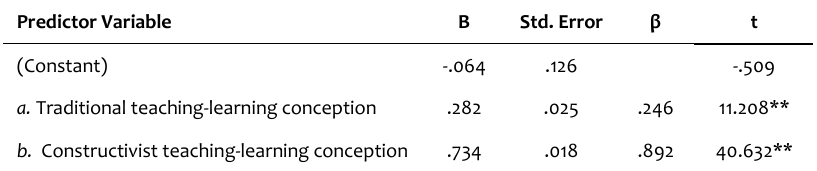
Table 5: Prediction Level of Teachers’ Teaching-Learning Conceptions